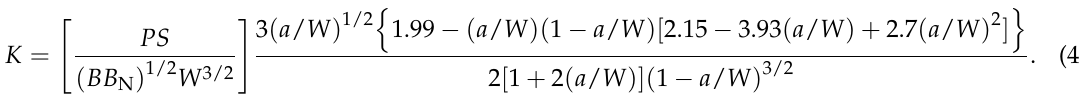
Figure 4. True stress–plastic strain curve for each temperature for HT780.